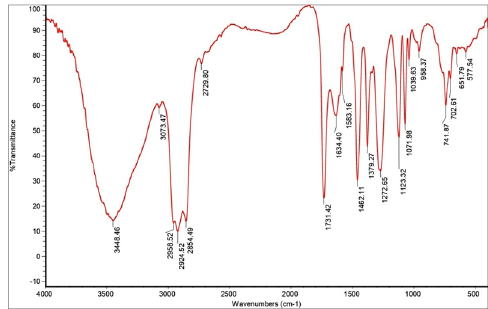
Fig. 3. FT/IR of un-inoculated Mineral salt-used engine oil (MS-OIL)